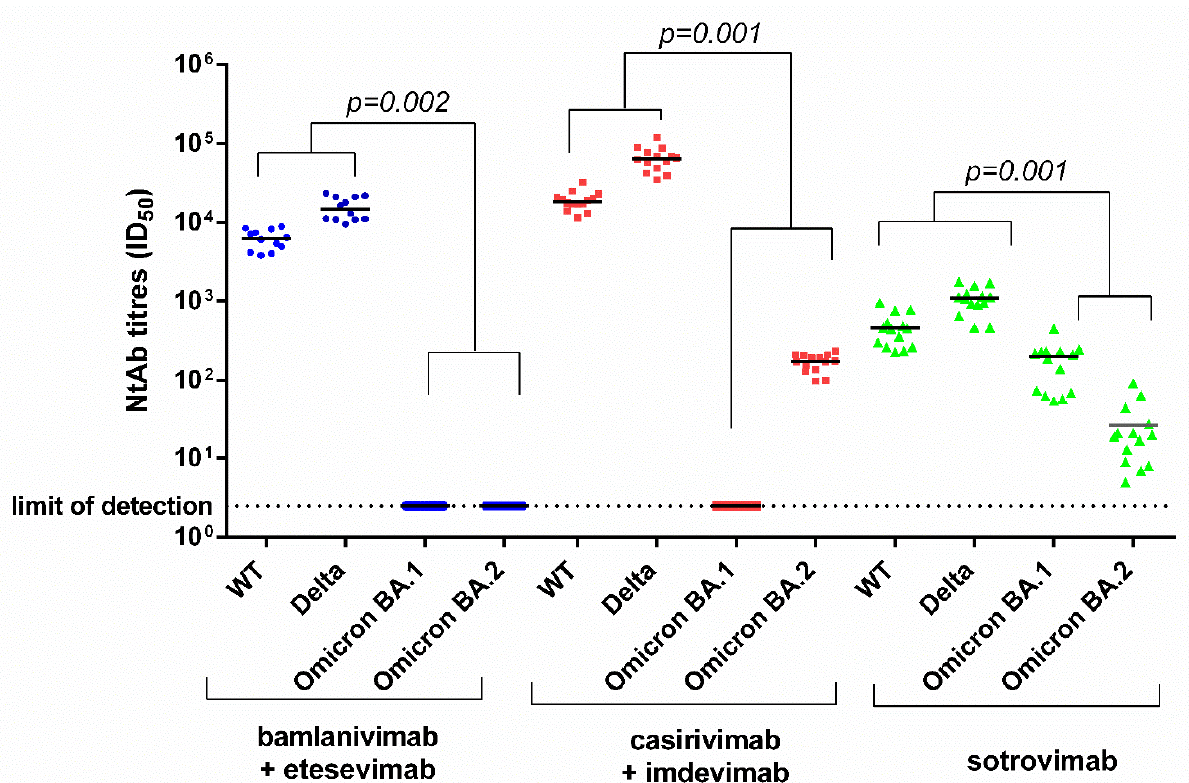
Figure 1. Ex vivo anti-SARS-CoV-2 wild type, delta, omicron (BA.1 and BA.2) neutralizing antibody titers measured in sera from 40 patients following infusion of bamlanivimab/etesevimab, casirivimab/imdevimab, or sotrovimab monoclonal antibodies. Blue dots, red squares and green triangles represents patients treated with bamlanivimab + etesevimab, casirivimab + indevimab and sotrovimab, respectively. Paired data were analyzed by the non-parametric Wilcoxon Signed Rank Sum test. NtAb titers before infusion were negative against each variant tested (not shown in figure). NtAb: neutralizing antibody; ID 50 : the reciprocal value of the sera dilution showing the 50% protection of virus-induced cytopathic effect; WT: wild type.